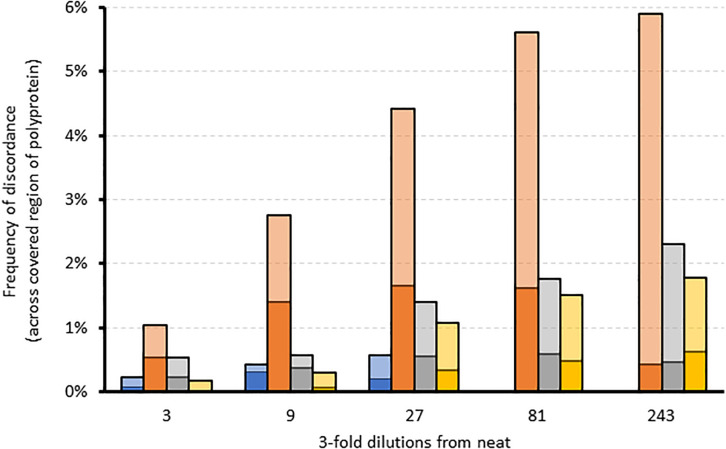
The effect of sampling bias on variant frequency detection using serial dilutions of different samples. Stacked bar graph comparing the frequency of amino acid (dark colors) and corresponding nucleotide (light colors) discordances across the region covered by each dilution relative to the corresponding neat sample. Blue = sample 1 (gt4a); Orange = sample 2 (gt2b); Gray = sample 3 (gt1a); Yellow = sample 4 (gt3a).